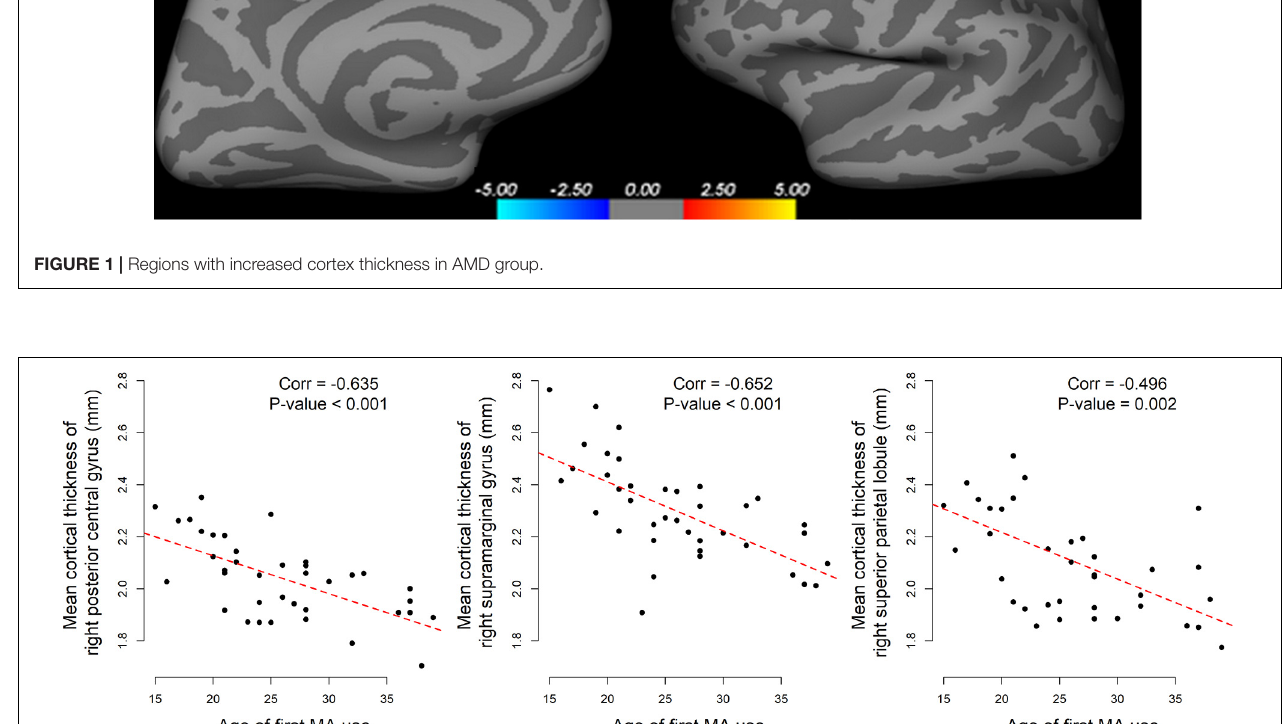
Frontiers in Human Neuroscience |